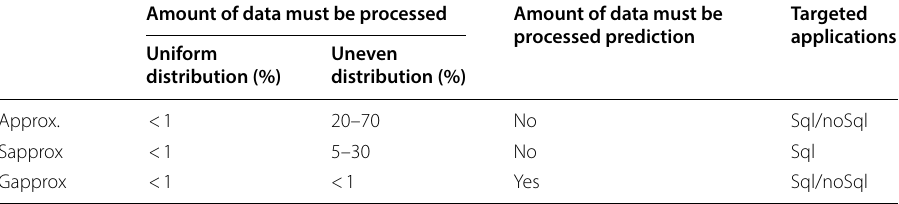
Table 2 Qualitative and quantitative analysis comparisons with other methodologies Amount of data must be processed Amount of data must be processed prediction Uniform Uneven distribution (%) distribution (%)